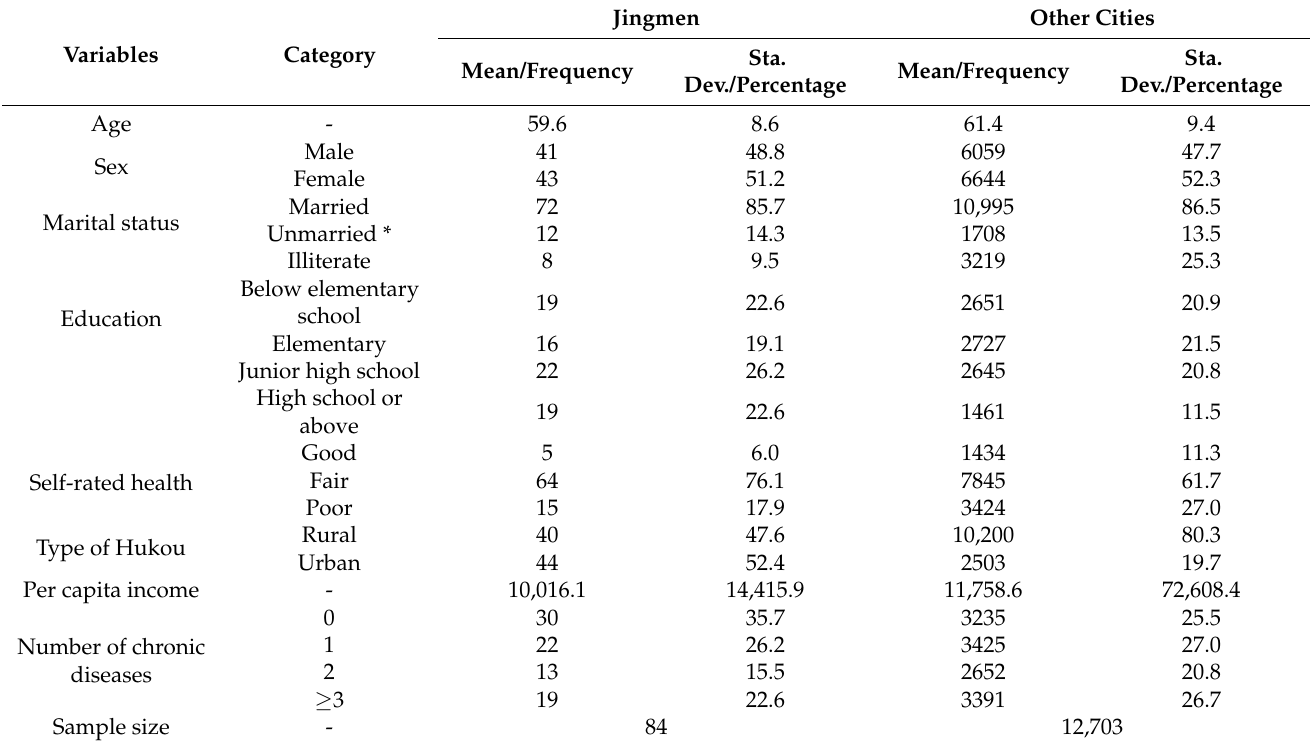
Table A1. Baseline characteristics of the observations.